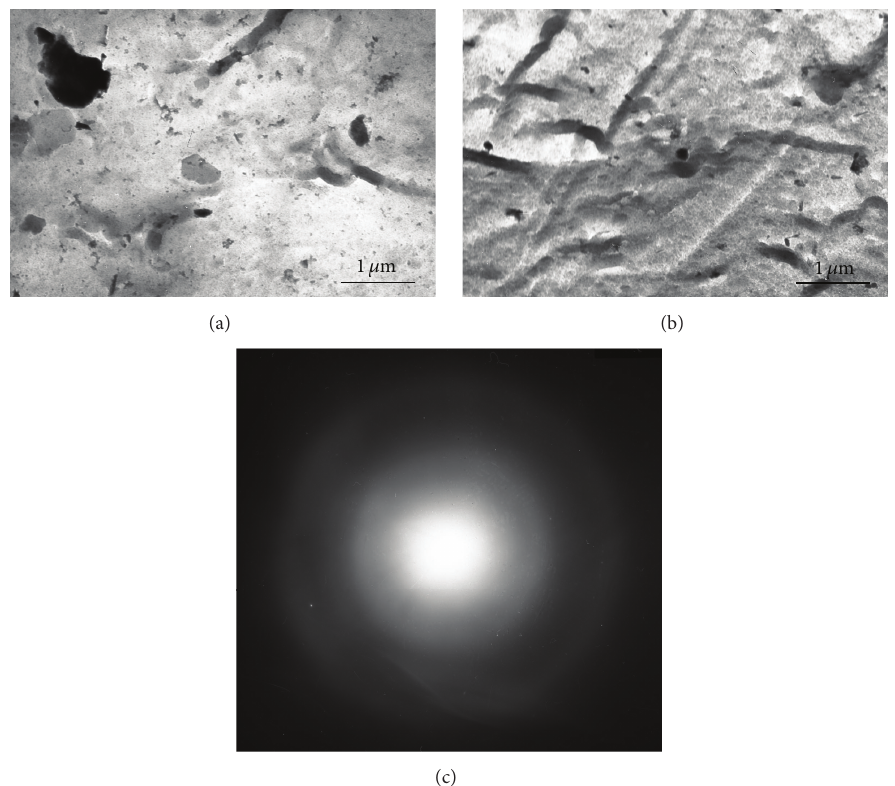
Figure 3: TEM microstructure of teenage dentin, bright field images; (a) image contained hexagonal crystals; (b) image contained traces of collagen fibers; (c) electron pattern. It is in the amorphous state.